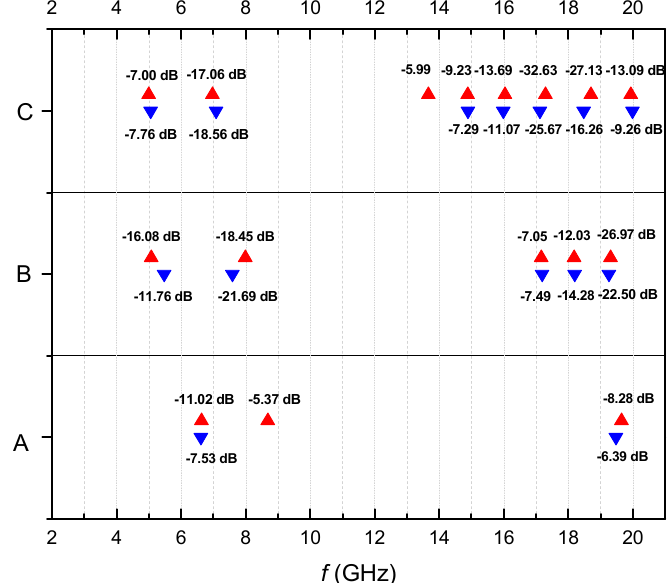
Figure 11. The main peaks (< − 5 dB) of the reflection losses for samples A, B and C vs. the frequency.